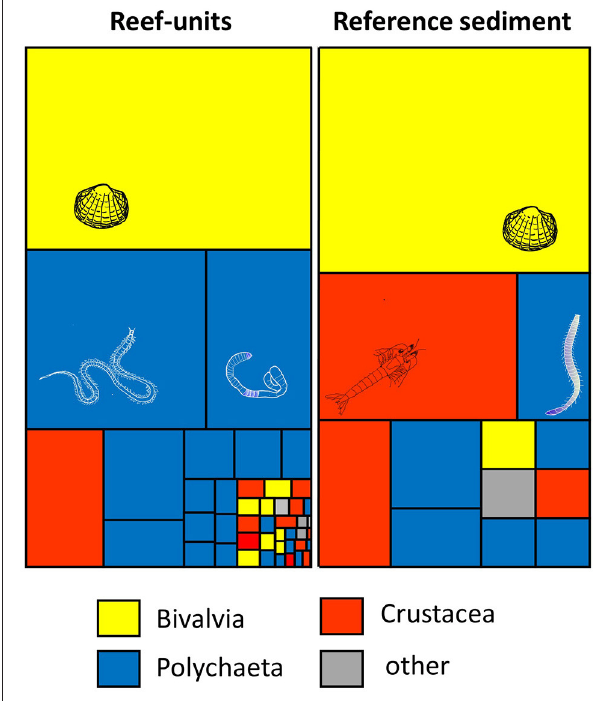
FIGURE 2 | Tree-map illustrating the number of invertebrate species in reef-units and reef-free sediment core samples. The size of tiles reflects the relative abundance of individual species (mean m − 2 ), the colour the taxonomic group; full species list in S1.